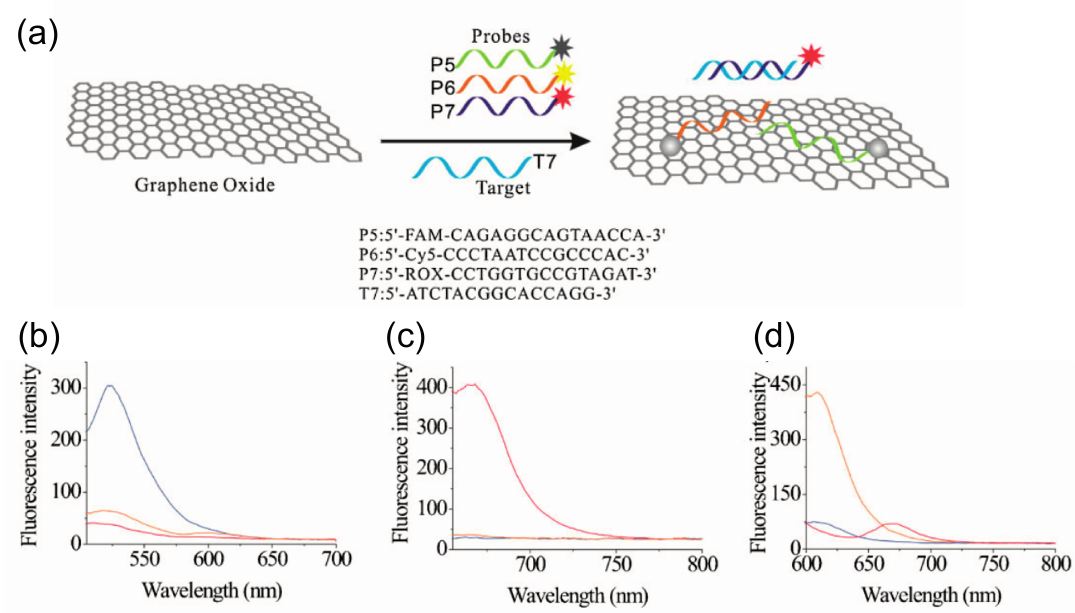
Figure 6. ( a ) Scheme showing DNA analysis using three probes (P5, P6, P7) in the presence of a blue T5 target; ( b – d ) fluorescence spectra for multicolor detection showing corresponding wavelengths when the probe is in the presence of different targets: (b) blue T5 at 494/526 nm/nm; (c) red T6 643/666 nm/nm; and (d) orange T7 587/609 nm/nm. Reproduced with permission from He et al. [90]. Copyright 2010 Advanced Functional Materials, John Wiley and